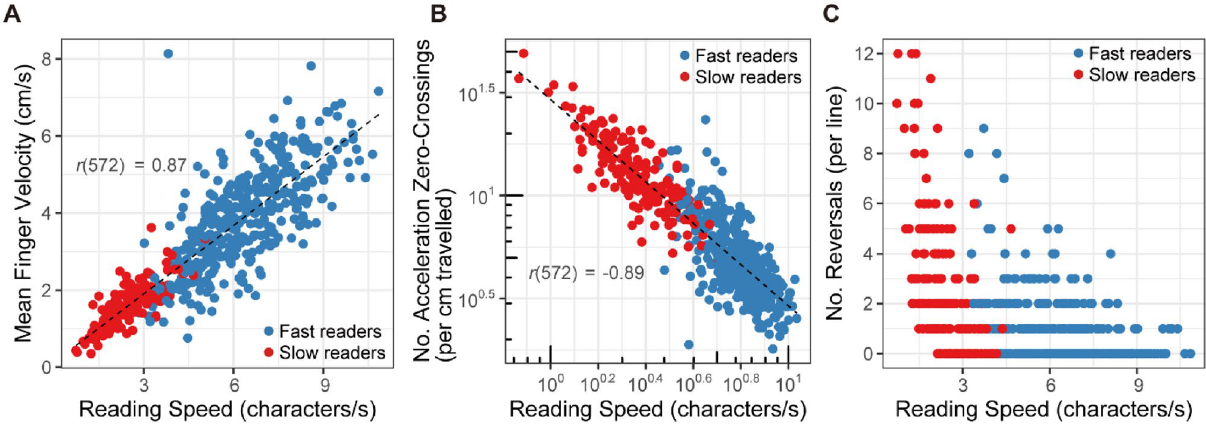
Figure 3. ( A ) The relation between mean finger velocity and reading speed ( r 2 = 0.77, p < 0.0001), ( B ) between number of acceleration zero-crossings and reading speed ( r 2 = 0.80, p < 0.0001), and ( C ) between number of reversals per line (whose values are always integer) and reading speed, colored according to the group (fast readers and slow readers). Recordings over multiple recording sessions and repetitions are pooled. Each variable is computed for each line of the braille passage. Figure prepared in R software (version 4.0.2, R Core Team, 2020, Vienna, Austria) 43